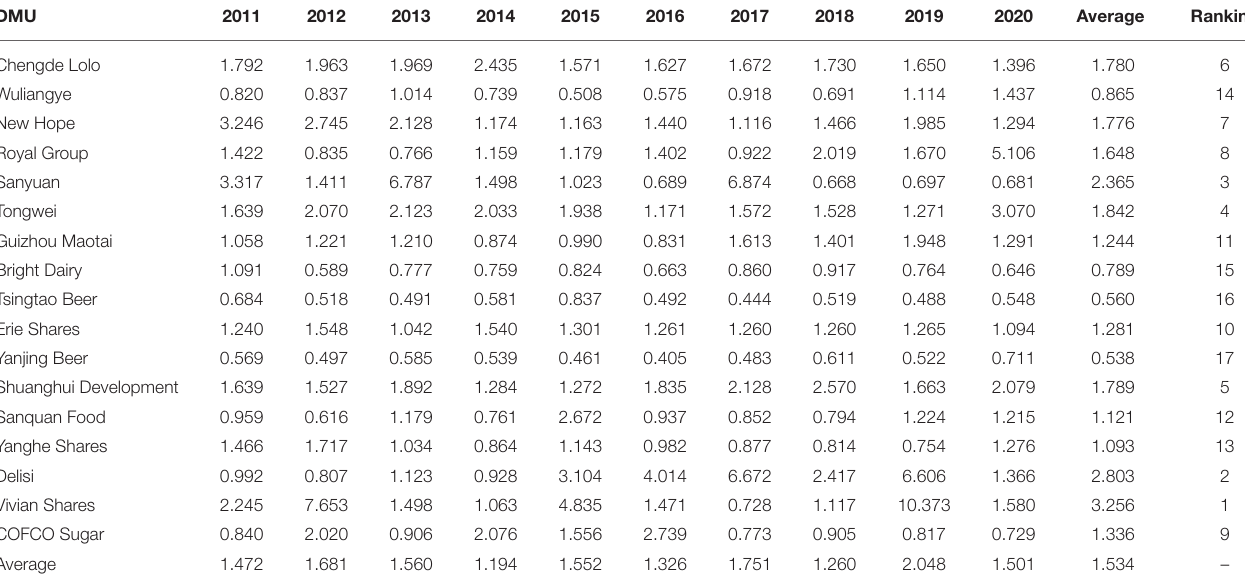
TABLE 3 | The super-efficiency data envelopment analysis (DEA) efficiency values of the 17 sample enterprises from 2011 to 2020. DMU